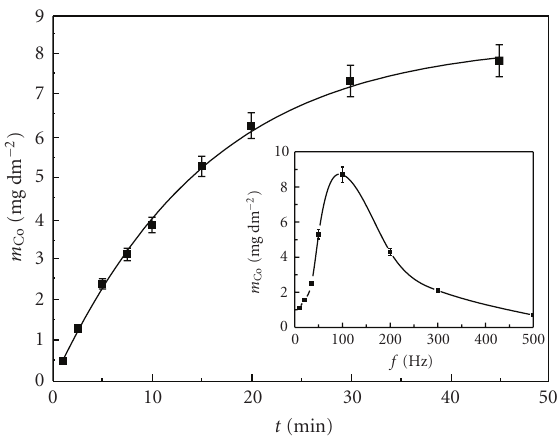
Figure 1: Variation of the amount of Co ( m Co ) inside the alumina pores for the deposition solution made of 0.2 cosO 4 , 0.7 H 3 BO 3 , , and TEA up to pH 5.7, at constant AC voltage U p − p 0.01 M MgSO 4 of 32 V, 50 Hz and 20 o C, as a function of the deposition time. Ø pore 15 nm; template thickness ( h AAO ) 15 μ m. In the inset, variation of m Co versus AC frequency ( f ) for the same deposition solution and U p − p value for 15 minutes of